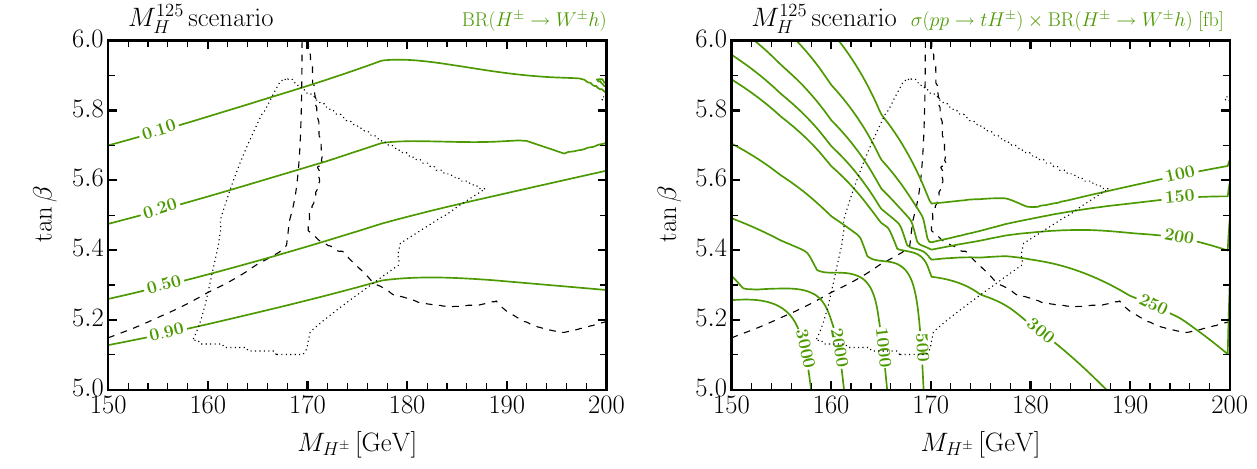
Fig. 11 Left: Branching ratio for the decay H ± → W ± h as a function of-mass energy. In each plot, the boundaries of the exclusion regions of M H ± and tan β in the M 125 scenario. Right: Total rate (in fb) for the from Fig.10 are shown as a dashed and a dotted black line, H production of a charged Higgs boson in association with a top quark, followed by the decay to a W ± h pair, at the LHC with 13 TeV center-